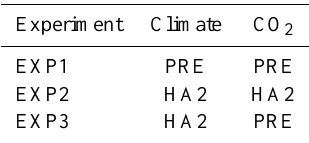
Table 1. List of all performed experiments for the 1850–2099 pe- riod. PRE represents preindustrial (i.e., 284.7ppm) whereas HA2 represents historical and IPCC-A2 emission scenario-based atmo- spheric CO 2